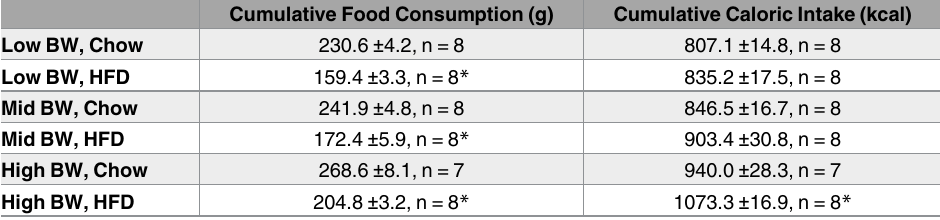
Table 1. Food consumption. Cumulative Food Consumption